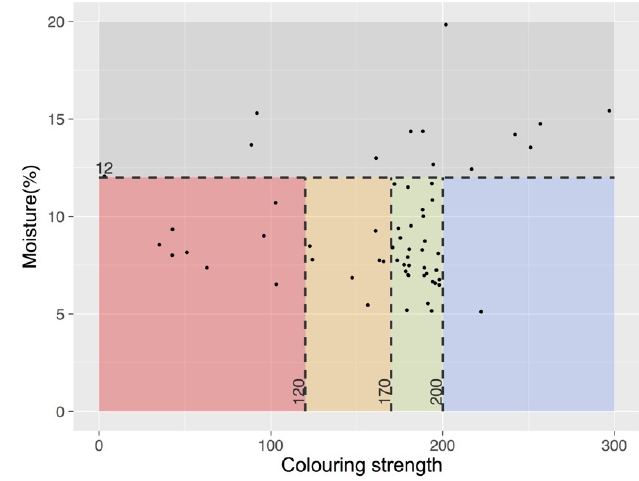
Fig. 7: Moisture content and colouring strength of saffron samples (black dots) not belonging to the first quality category. The broken lines and the background colors define the limits of the three quality catego- ries according to ISO 3632